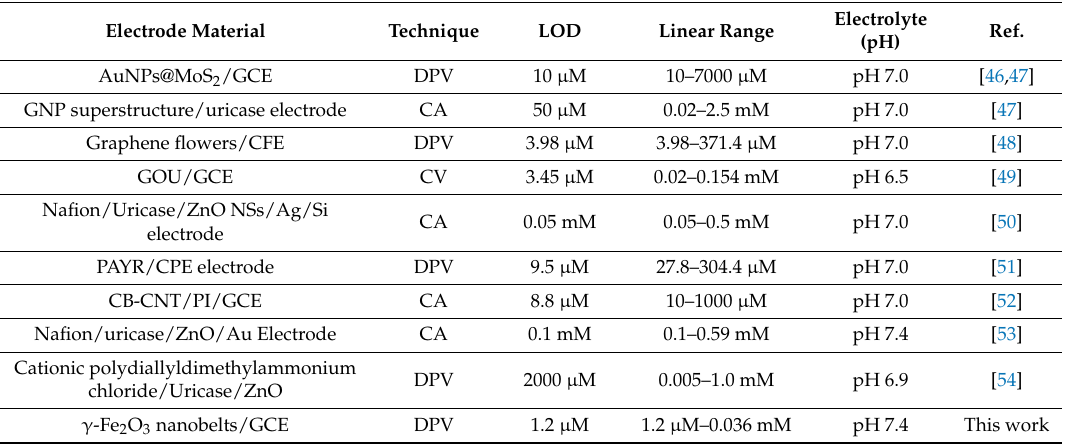
Table 1. Comparison of UA sensor parameters of γ -Fe 2 O 3 nanobelts/GCE and the other electrode materials reported in